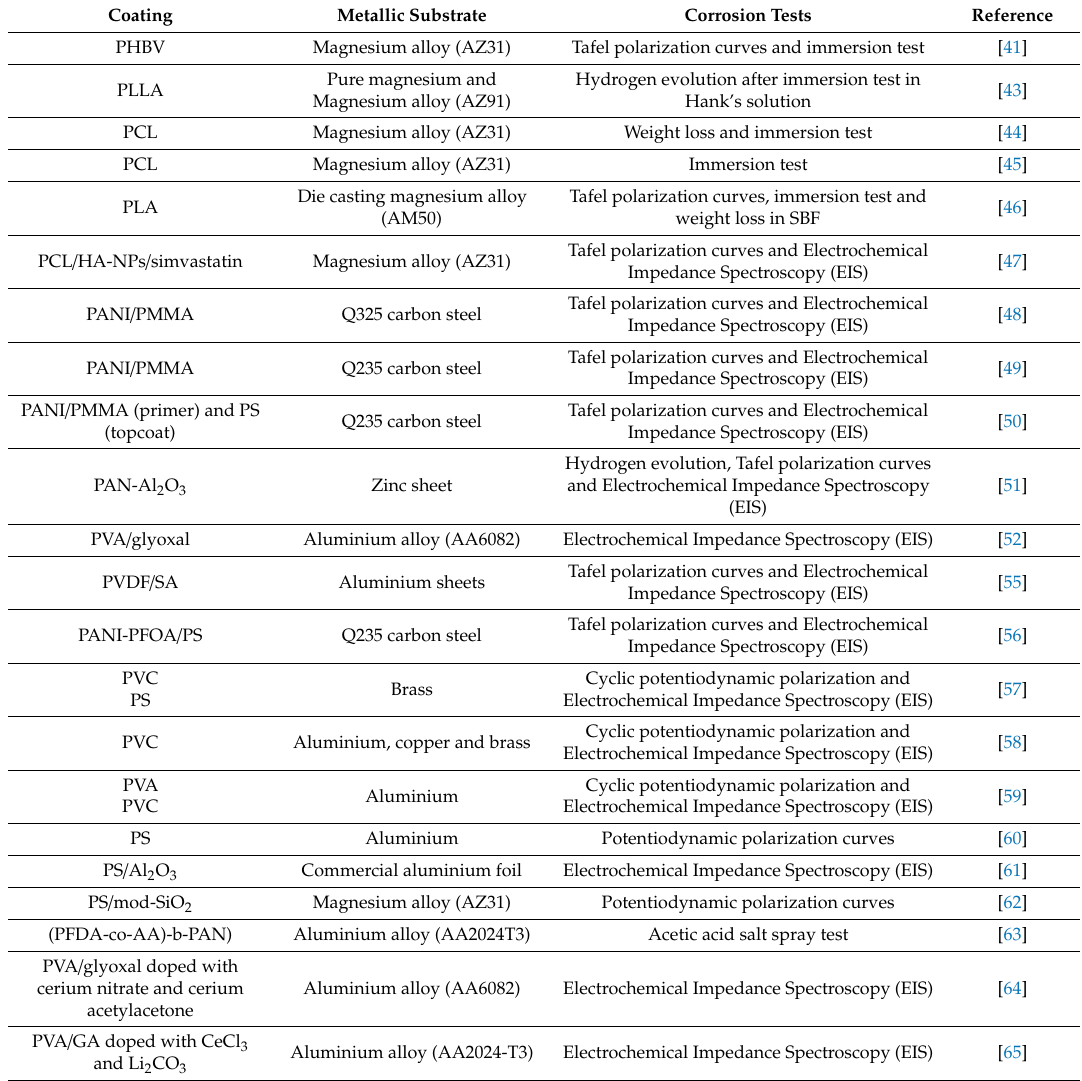
Table 1. Summary of the di ff erent sensitive electrospun coatings, the metallic substrates used and the resultant corrosion tests for the development of new and innovative protective coatings with good anticorrosion